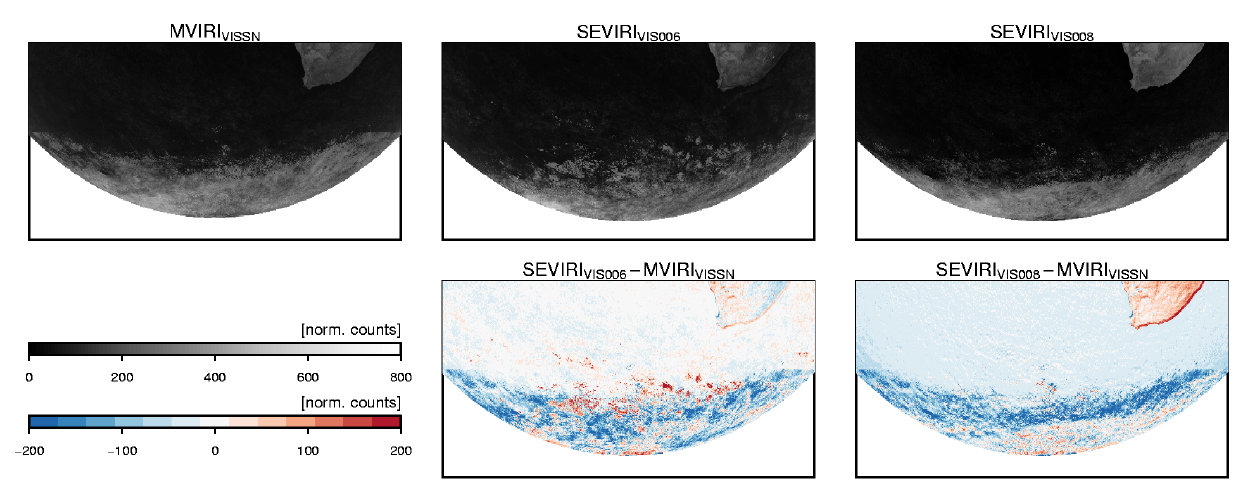
Figure 8. Clear sky normalized counts ρ MVIRI and SEVIRI visible channels for January 2005 (12 UTC